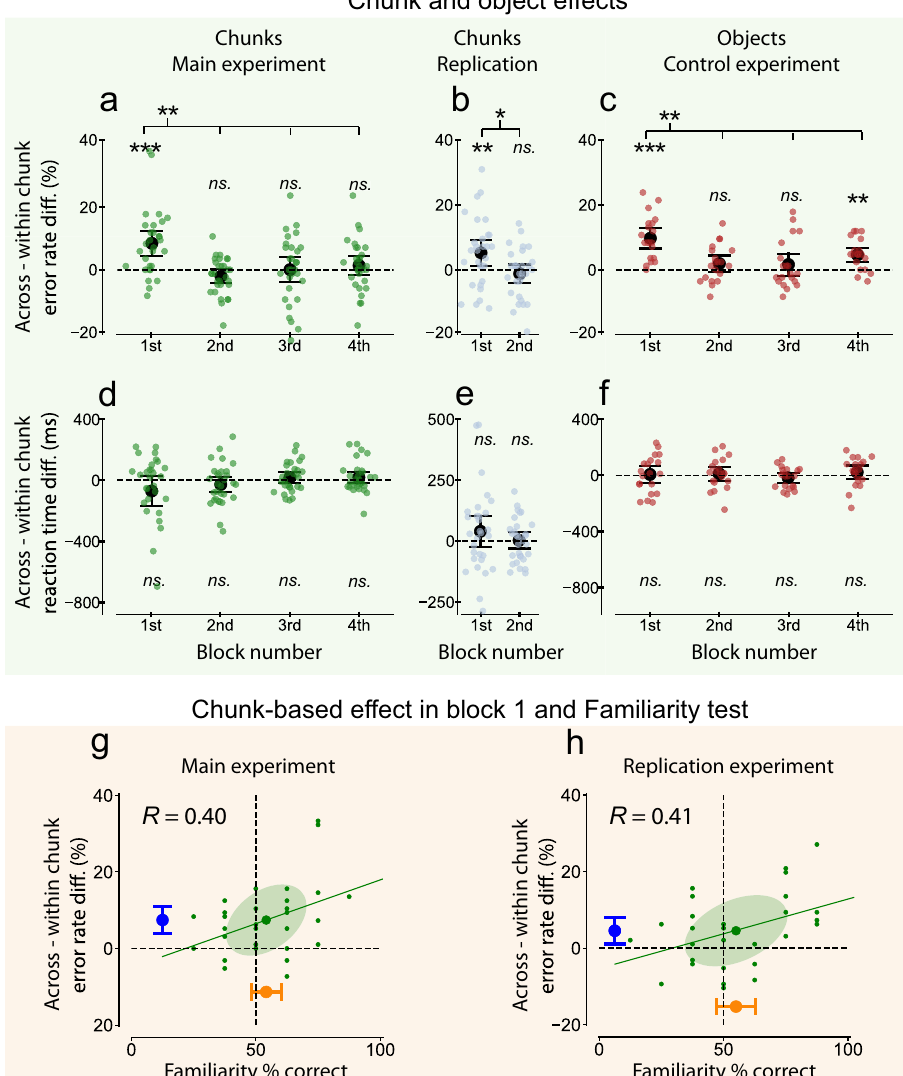
Fig. 2 Chunk- and object-based error rate effects in Experiment 1. a – f Chunk/object-based error rate ( a – c ) and reaction time ( d – f ) effects across Exps 1a, 1b, and 1c. Mean error rate and median reaction time differences between the across-chunk and within-chunk trials ( y axis) in each Search block ( x axis) in the main ( a ) and in the replication ( b ), and in the control ( c ) experiments. Positive values mean fewer errors or faster responses in within-chunk compared to across-chunk trials and error bars show the 95% con fi dence intervals of the mean. Colored dots represent the mean error rates or median reaction time differences of the observers in a given block. g , h The relationship between performance in the Familiarity test ( x axis) and error rate differences of the across-chunk vs. within-chunk trials in the fi rst block ( y axis) in the main ( g ) and in the replication ( h ) experiments. Green error ellipses show one standard deviation and green lines represent best- fi tting linear regression lines. The error bars show the 95% con fi dence intervals of the mean performance in the Familiarity test (orange), and of the average chunk-based error rate effect (blue). n = 30 in Exp. 1a ( a , d , g ), n = 30 in Exp. 1b ( b , e , h ), and n = 20 in Exp. 1c ( c , f ). Signi fi cant differences from zero in a – f are indicated with ns. p > 0.05, * p < 0.05, ** p < 0.01, *** p < 0.001, two-tailed paired (the difference between across and within-chunk trials) t -tests. R -values in g and f indicate Pearson correlation coef fi cients. Source data are provided in the Source Data fi le (Fig. 2 worksheet tab in Source